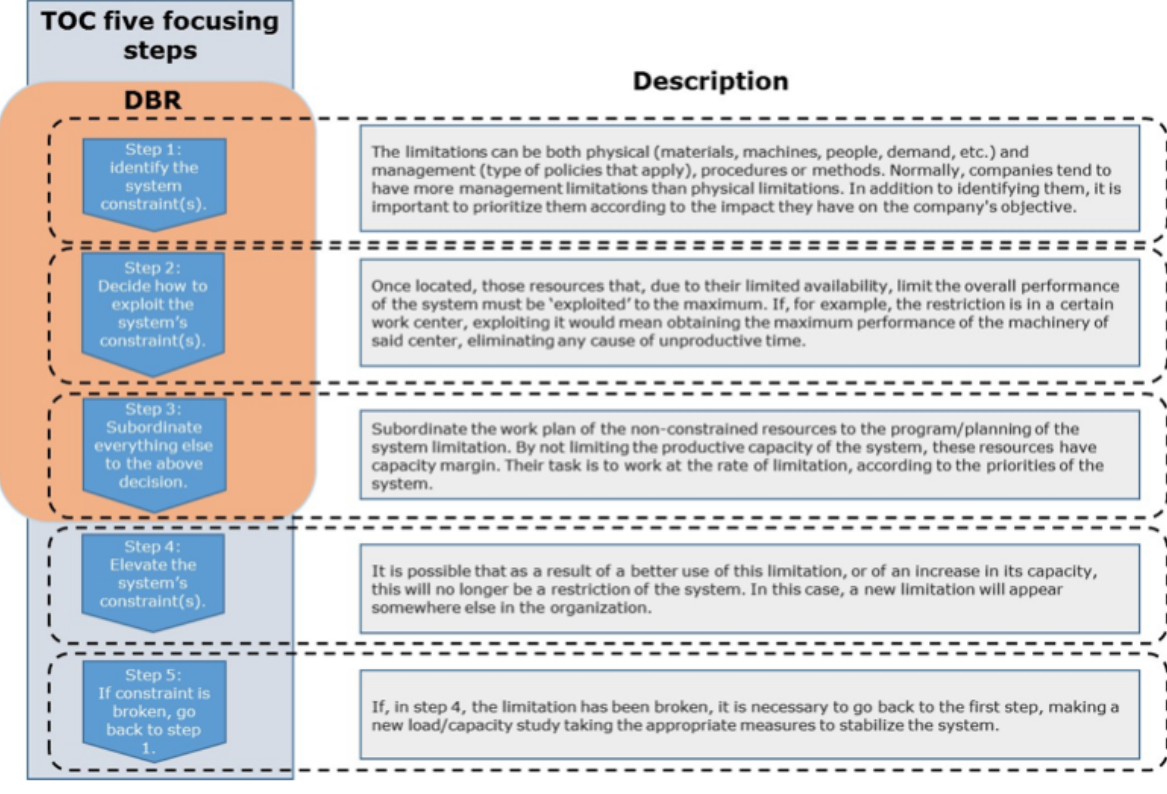
Figure 1. Five focusing steps of the TOC and DBR limited to first three steps (Lizarralde et al.,